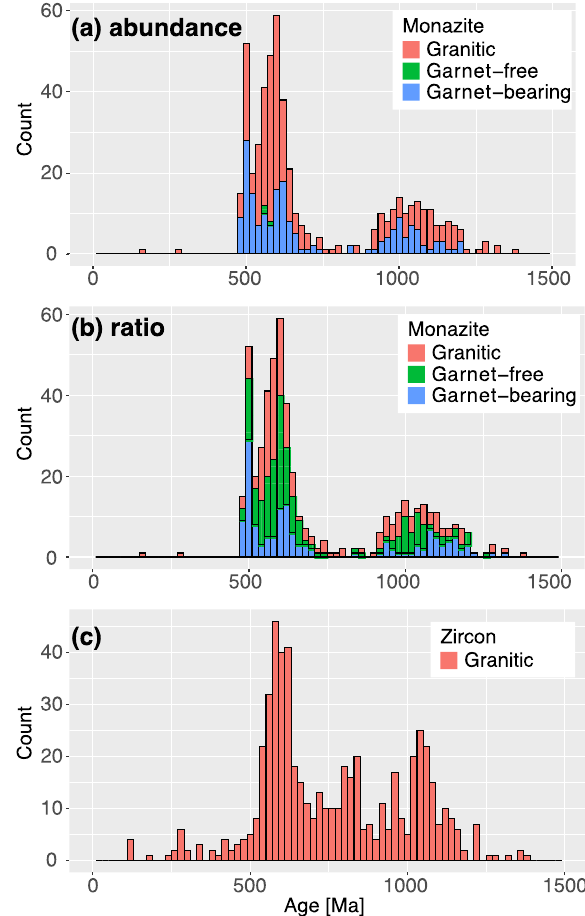
Figure 5. ( a , b ) U–Pb age histograms of detrital monazite and ( c ) zircon from five African rivers (data from Itano et al. 2016). The cumulative relative frequencies were calculated for each river. The source rock type was classified into granitic (red), garnet-free (green), and garnet-bearing metamorphic rocks (blue), with ( a ) the elemental-ratio-based and ( b ) elemental-abundance-based discriminations.